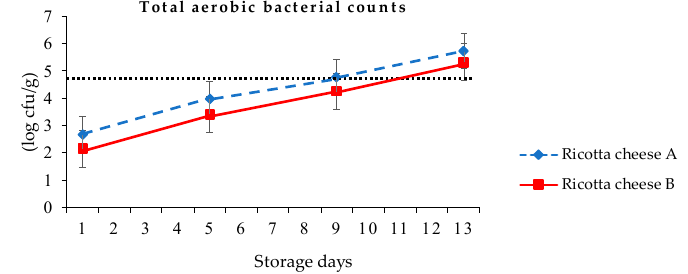
Figure 5. Total aerobic bacterial counts of ricotta cheeses A (80/20 cow cheese whey/skimmed goat milk) and B (80/20 cow cheese whey/full-fat goat milk) at 4 °C storage. Table 5. The pH value and titratable acidity of ricotta cheese during storage (replicated for three different samples) .